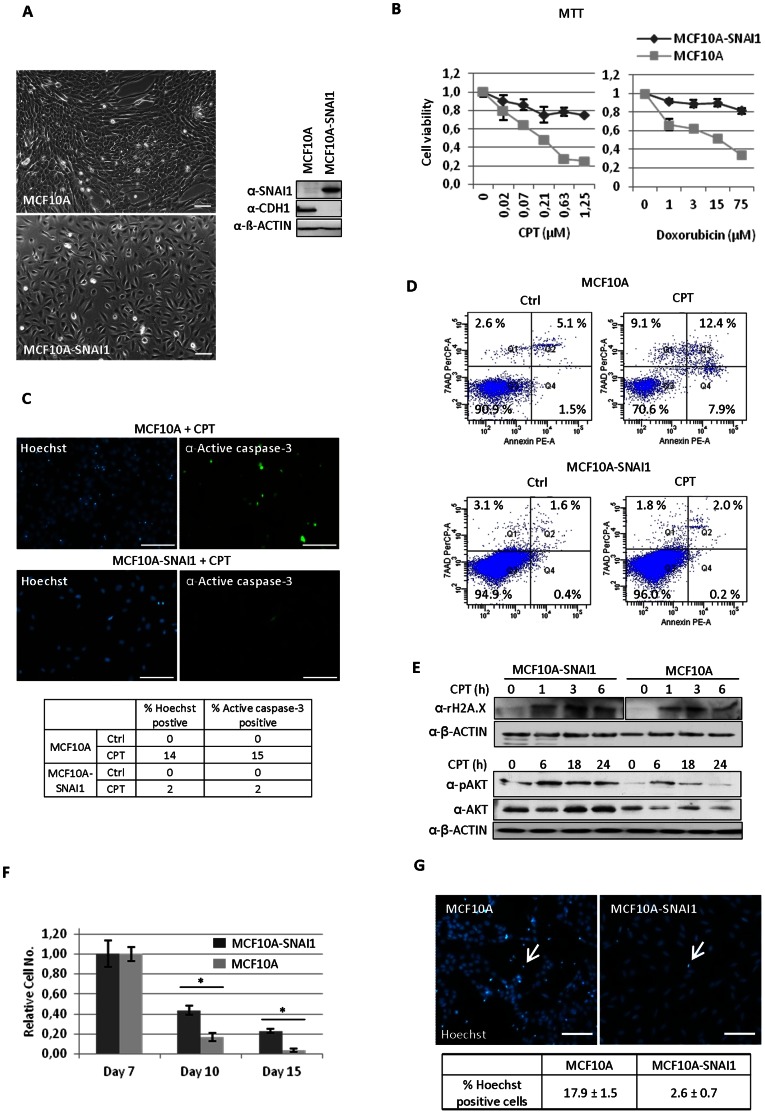
EMT generates cells with increased resistance to cell death.(A) MCF10A cells stably expressing SNAI1 (MCF10A-SNAI1) induced an EMT as shown by fibroblast-like appearance. Bar = 10 µm. Western blot analysis showed down-regulation of the epithelial marker, E-cadherin (CDH1) in SNAI1-overexpressing cells. (B) MCF10A-SNAI1 cells were more resistant to camptothecin (CPT) - and doxorubicin-induced cell death, as determined by MTT analysis. (C) MCF10A-SNAI1 cells were more resistant to the CPT-induced apoptosis as revealed by Hoechst staining and immunofluorescence using anti-active caspase-3 antibody. Positive cells for Hoechst or active caspase-3 staining were counted in the table. Bar = 100 µm. (D) Using Annexin V apoptosis detection kit, apoptotic cells were quantified upon CPT treatment (24 h). Viable cells are Annexin V-PE and 7-AAD-PerCP negative, and cells that are in early apoptosis are Annexin V-PE positive and 7-AAD-PerCP negative. Cells that are in late apoptosis or already dead are both Annexin V-PE and 7-AAD-PerCP positive. (E) To investigate the cellular response to CPT-induced DNA damage, western blot analysis was performed using antibody against γ-H2A.X, which is an indicator for DNA repair response. No difference in the accumulation of γ-H2A.X was observed in two cell lines for the indicated times, whereas MCF10A-SNAI1 cells showed higher AKT activation 6, 18 and 24 h after CPT treatment. (F) Serum-depletion for 10–15 days induced more cell death in MCF10A cells than MCF10A-SNAI1 cells as determined by a trypan blue assay. *P<0.05. (G) Hoechst positive cells upon serum-depletion were counted in three independent fields under a fluorescence microscopy. Bar = 100 µm.